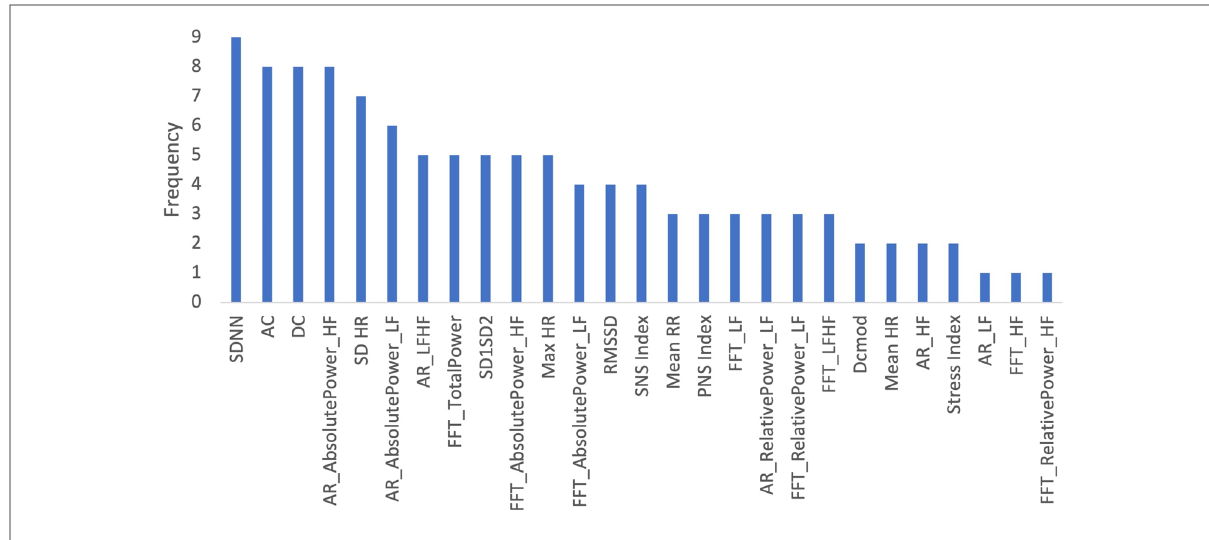
FIGURE 19 Frequency of features in all